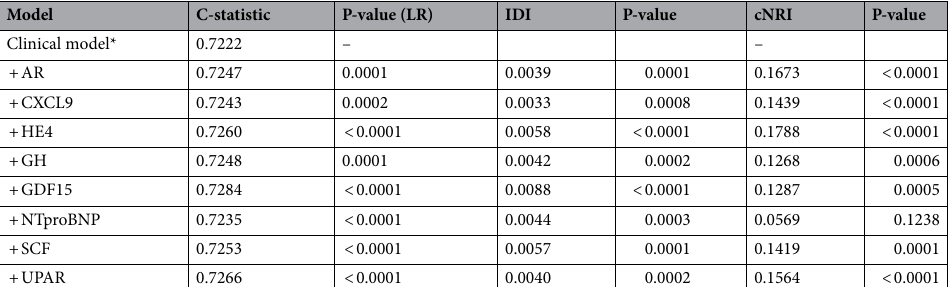
Table 2. Performance metrics of individual plasma proteins in addition to clinical covariates for prediction of all-cause mortality in the MDCS-CVA. LR likelihood ratio test, cNRI category-free Net Reclassification Improvement, IDI integrated discrimination improvement. *Cox regression model including age, sex, smoking status, BMI, educational level, history of hypertension, prevalent diabetes mellitus, C-reactive protein (ln-transformed), HbA1c (ln-transformed), and